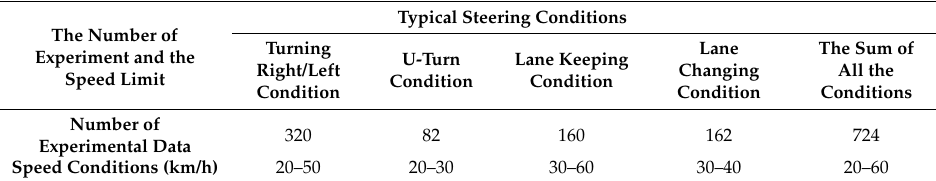
Table 3. Actual experimental data and speed conditions.